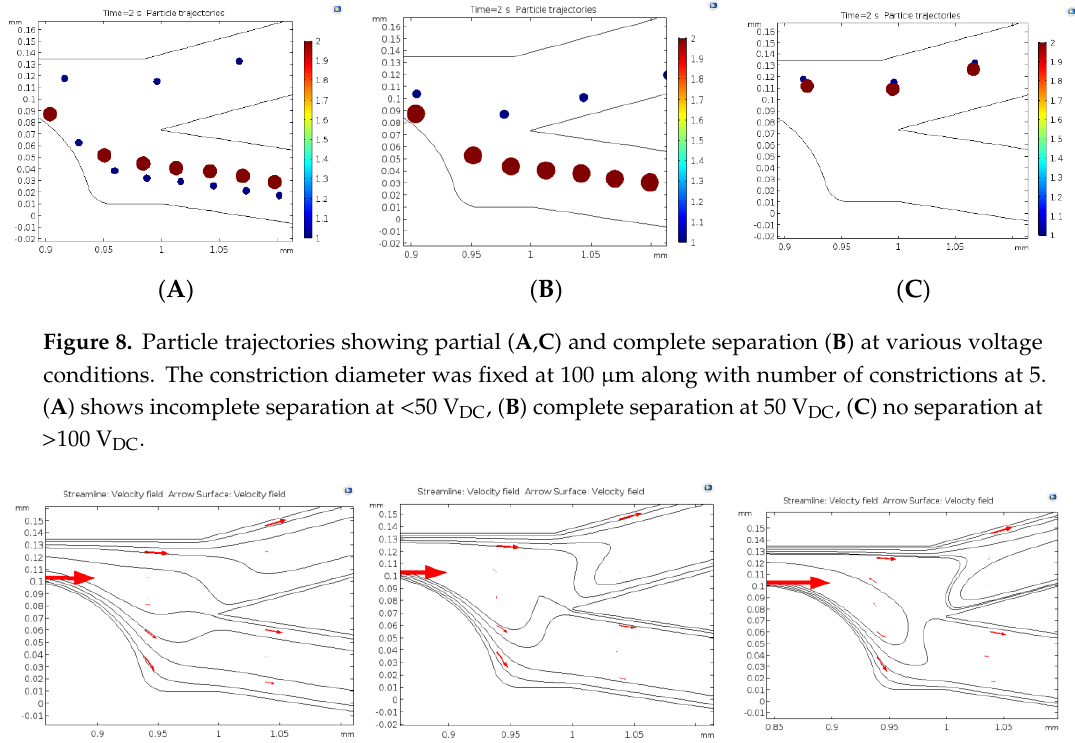
Figure 8. Particle trajectories showing partial ( A , C ) and complete separation (B) at various voltage conditions. The constriction diameter was fixed at 100 µm along with number of constrictions at 5. ( A ) shows incomplete separation at <50 V DC , ( B ) complete separation at 50 V DC , ( C ) no separation at >100 V DC .